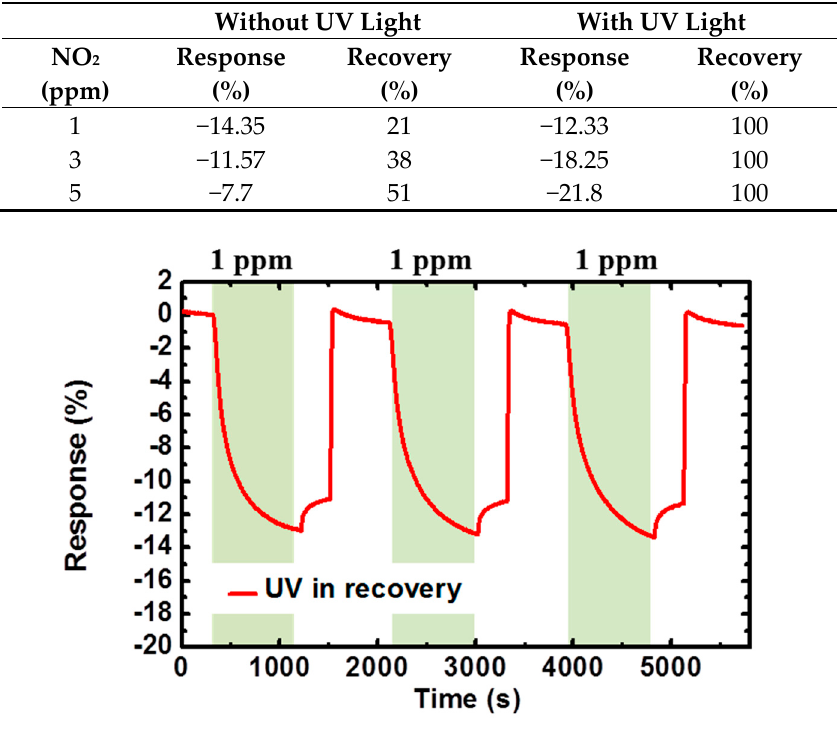
Figure 3. Repeatability and stability studies of the graphene sensor exposed to NO 2 gas of 1 ppm.